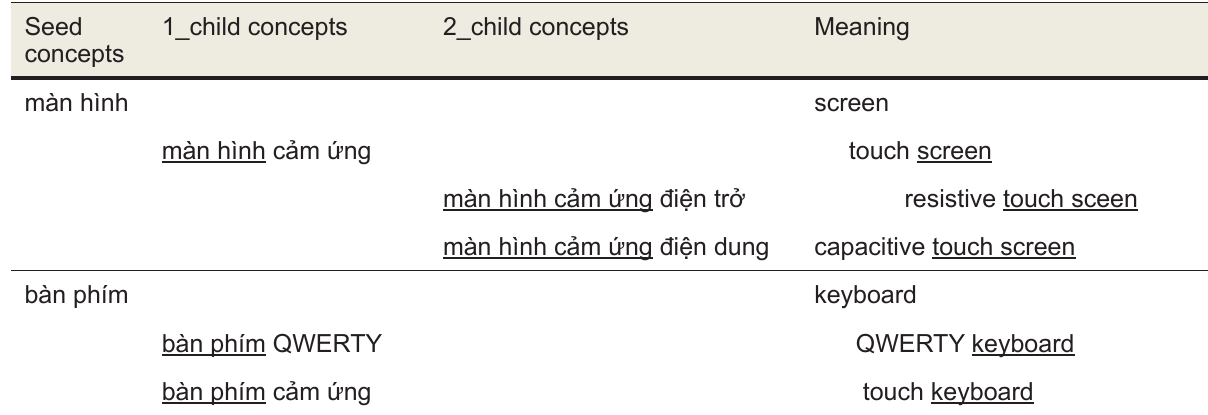
An Example of Child-Concepts Generalization using Seed Concepts and Prefix-Based Con- cept Discovery